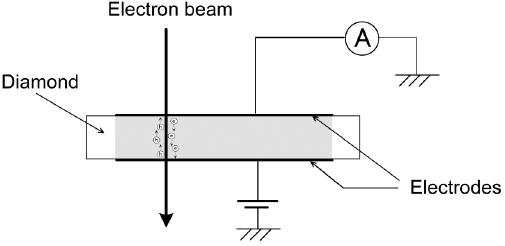
FIG. 1. Principle of the diamond-based